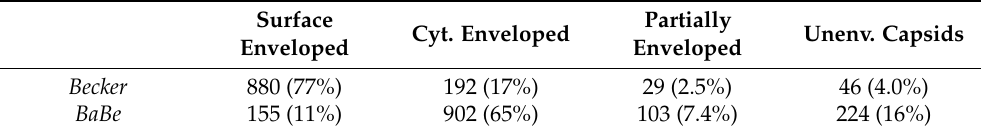
Table 1. Cytoplasmic and cell surface forms of PRV particles associated with CAD neurons . Surface Partially Cyt. Enveloped Unenv. Capsids Enveloped Enveloped Becker 880 (77%) 192 (17%) 29 (2.5%) 46 (4.0%) BaBe 155 (11%) 902 (65%) 103 (7.4%) 224